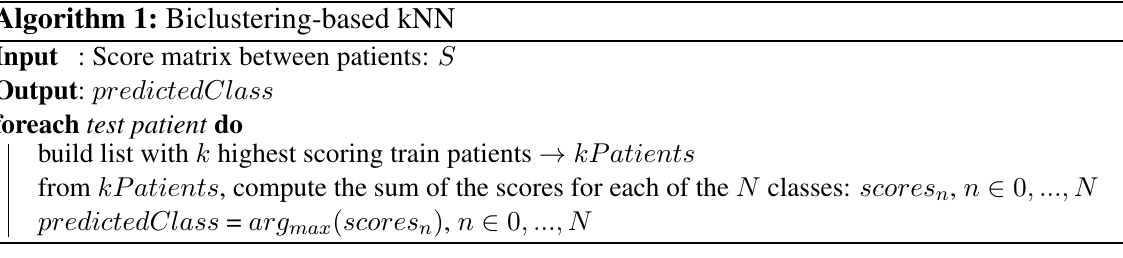
Algorithm 1: Biclustering-based